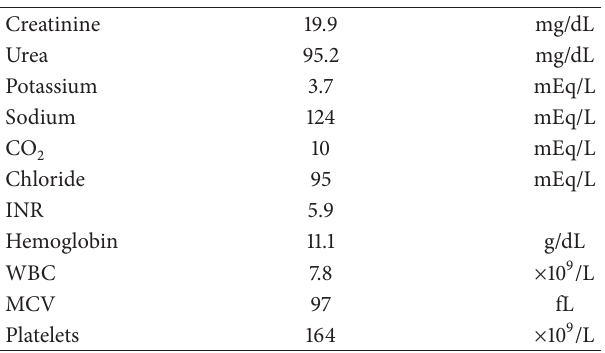
Table 1: Basic laboratory data on admission.